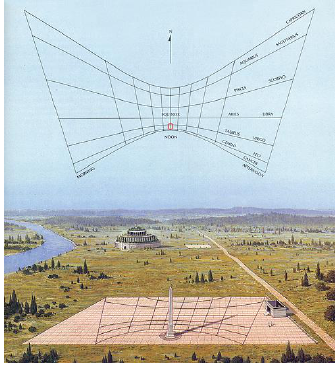
Figure 11: Horologium of Augustus on Campo Marzio according to Buchner